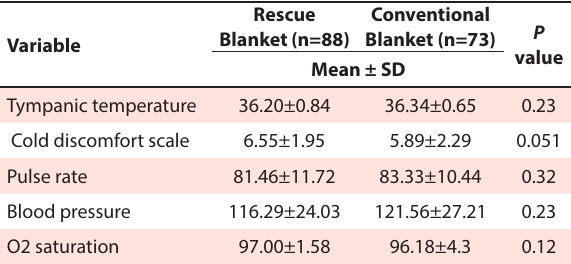
Table 1. Basic information of participants